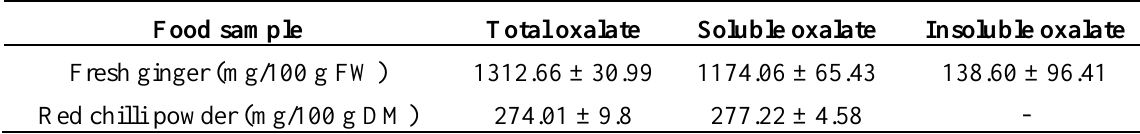
Table 3. Mean total soluble and insoluble oxalate contents of materials used to make kimchi. FW, fresh weight; DM, dry matter.